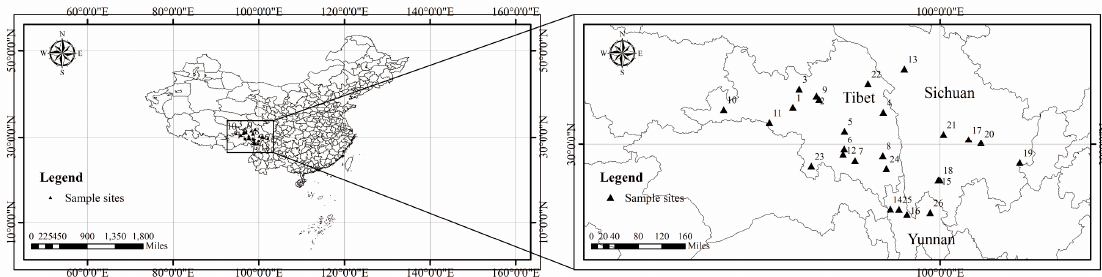
Figure 1. Sampling sites of conifer needles and twigs (fir and spruce) in the eastern Tibetan Plateau, China.